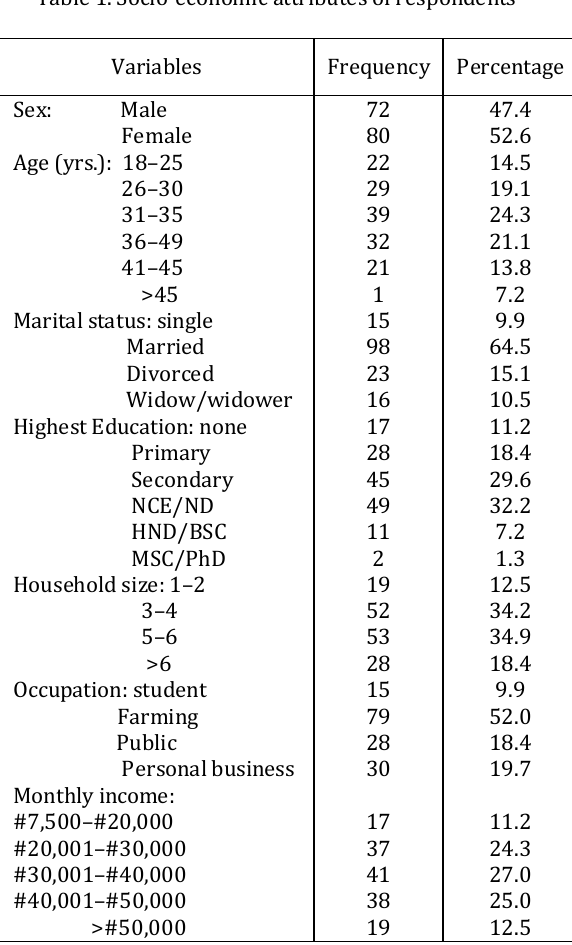
Table 1. Socio-economic attributes of